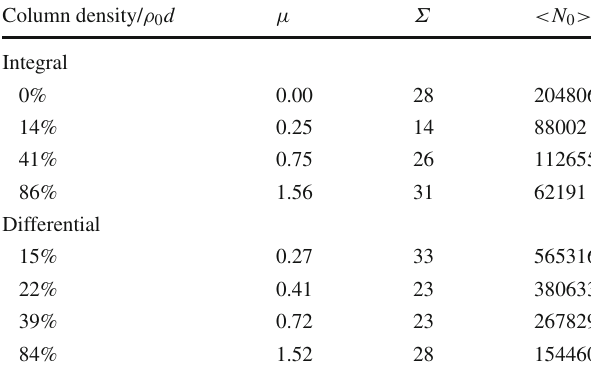
Table 1 A summary of the number of scans Σ performed at different column densities relative to the nominal value ρ 0 d . The corresponding scattering probability μ is also shown. The average number of counts < N > per 50-mV bin for the unscattered electrons at E 0 [2eV , 10eV] is provided for the integral dataset, as well as the sum of all unscattered electrons N 0 at E s ∈ [ − 1eV , 1eV] for the